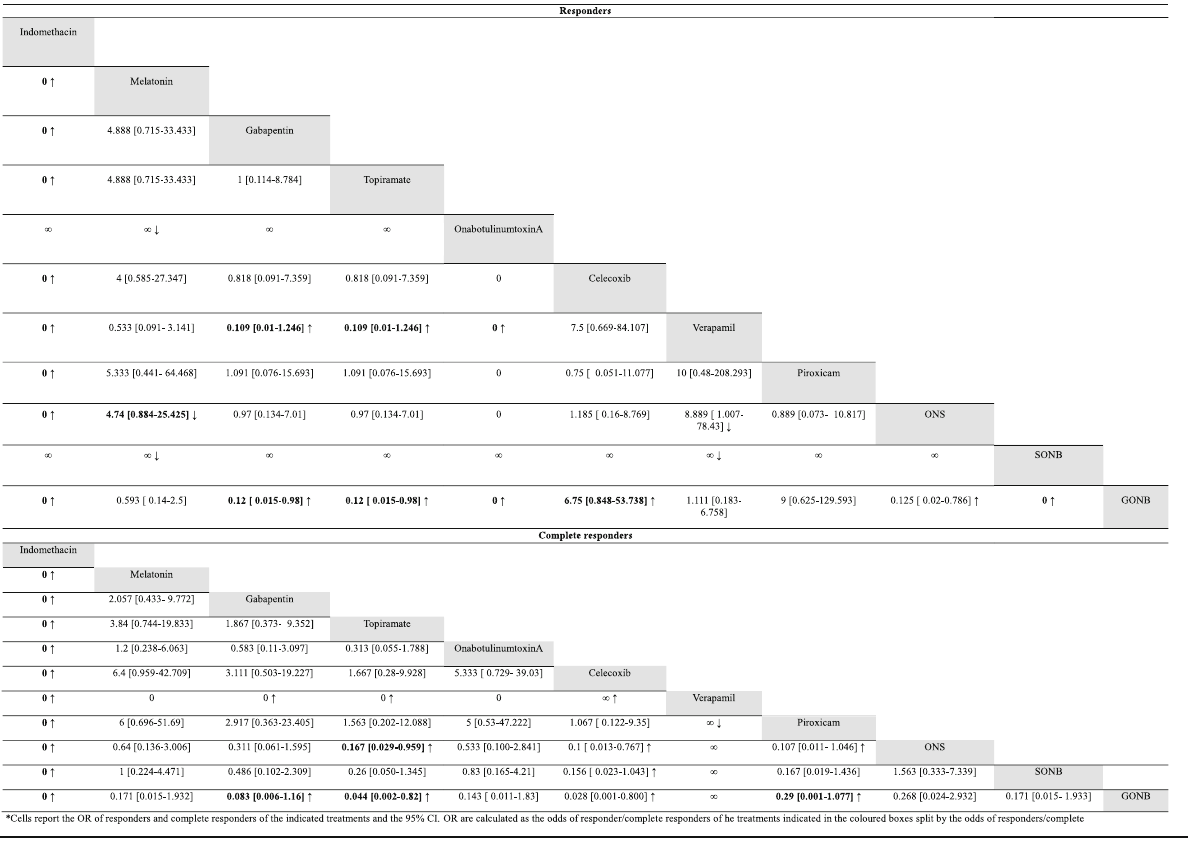
Table 3 comparisons between the odds of responders and complete responders of prolonged treatments for HC*